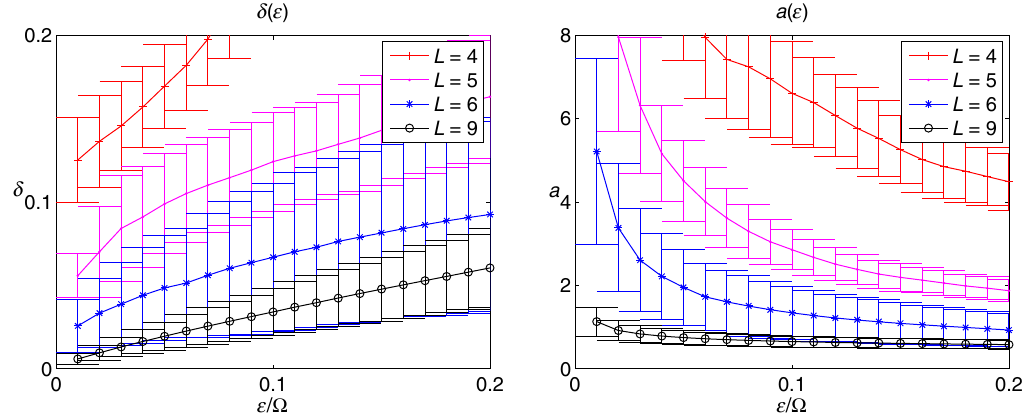
γ ¼ Ω and standard λ with mean